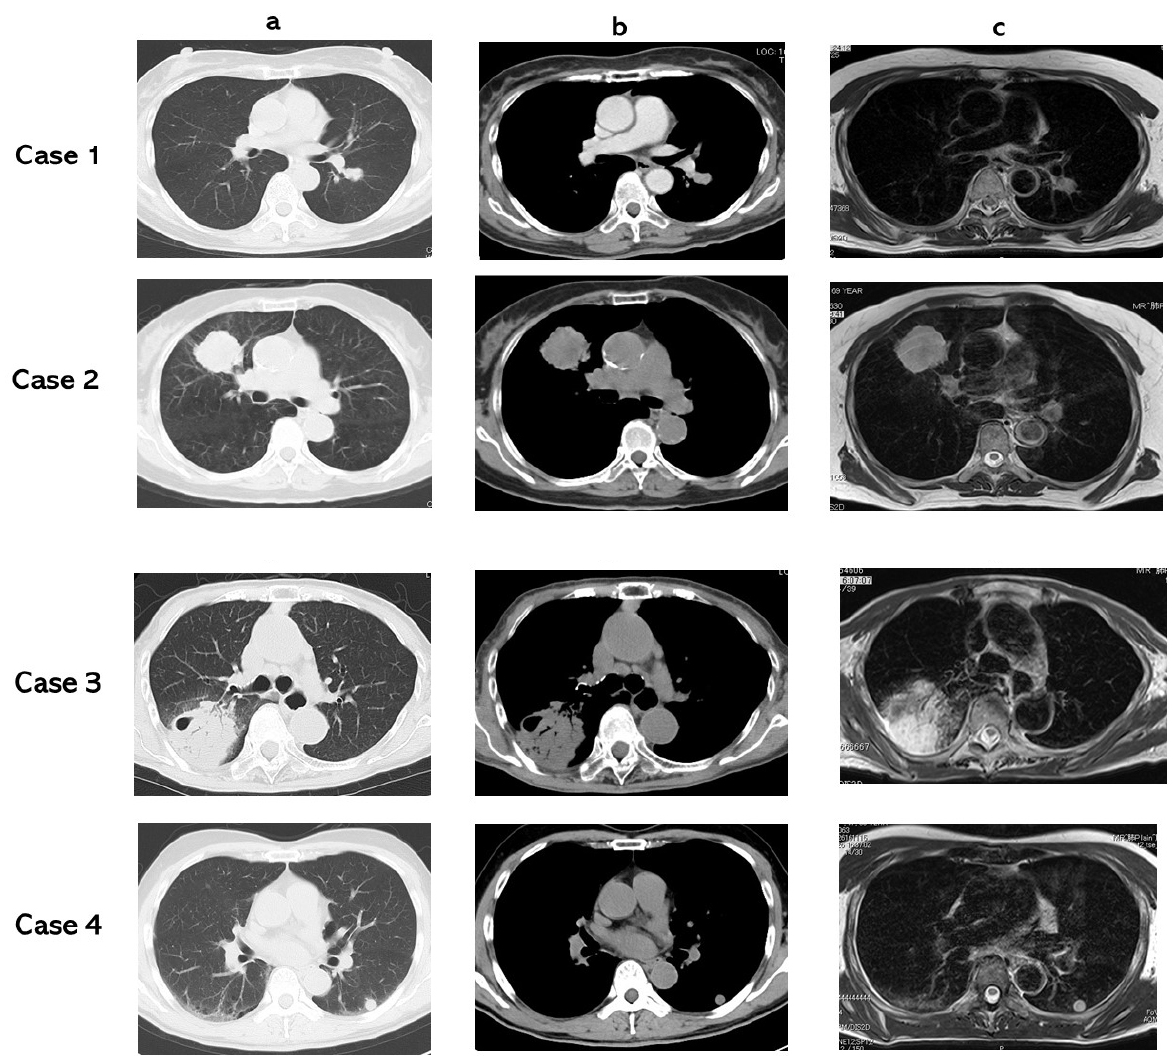
Figure 1. ( a ): CT lung window setting, ( b ): CT mediastinal window setting, ( c ): T2 WI. Case 1: adenocarcinoma, T2 CR: 2.03. Case 2: squamous cell carcinoma, T2 CR: 2.43. Case 3: non-tuberculous mycobacteria, T2 CR: 3.52. Case 4: hamartoma, T2 CR: 2.95.